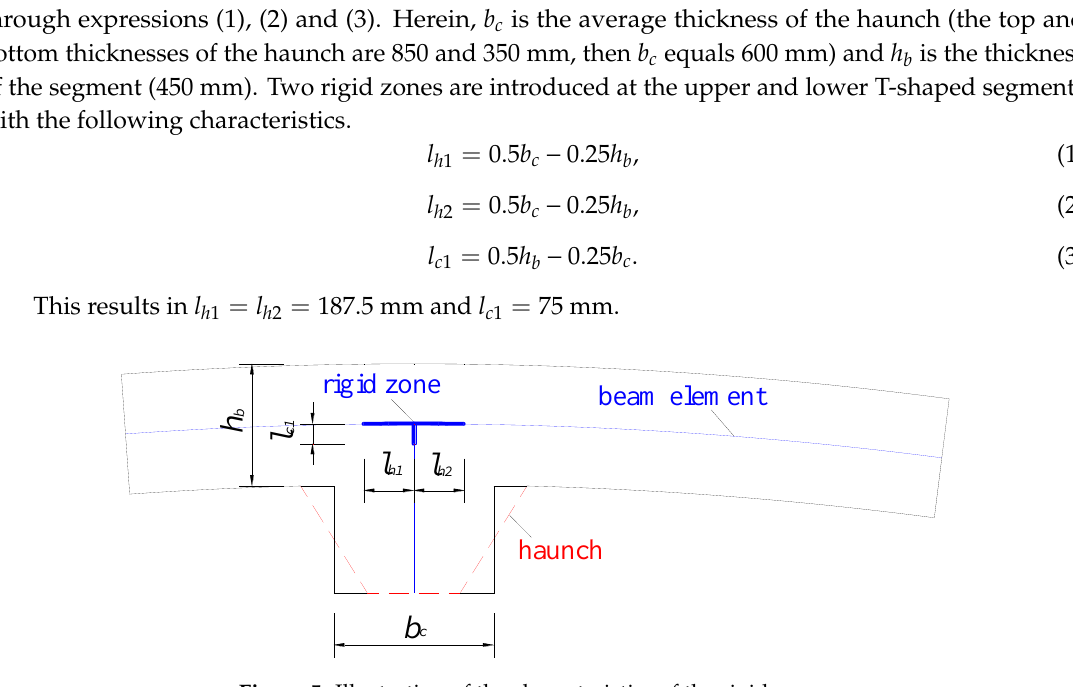
Figure 5. Illustration of the characteristics of the rigid zone.